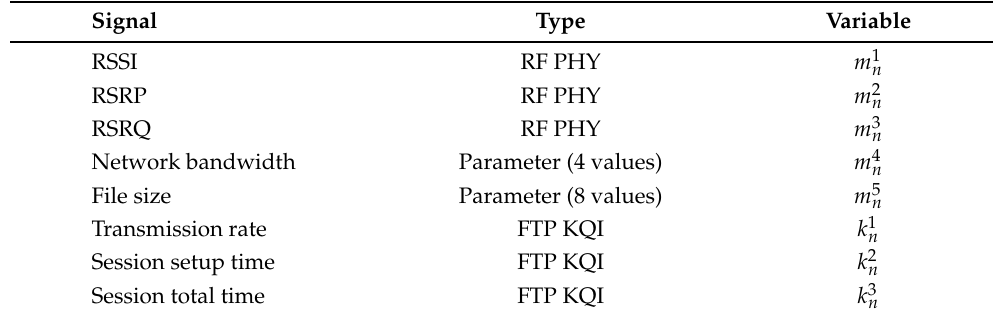
Table 2. Dataset used in the experiments from UMAHetNet. RSRP, reference signal received power; RSRQ, reference signal received quality.